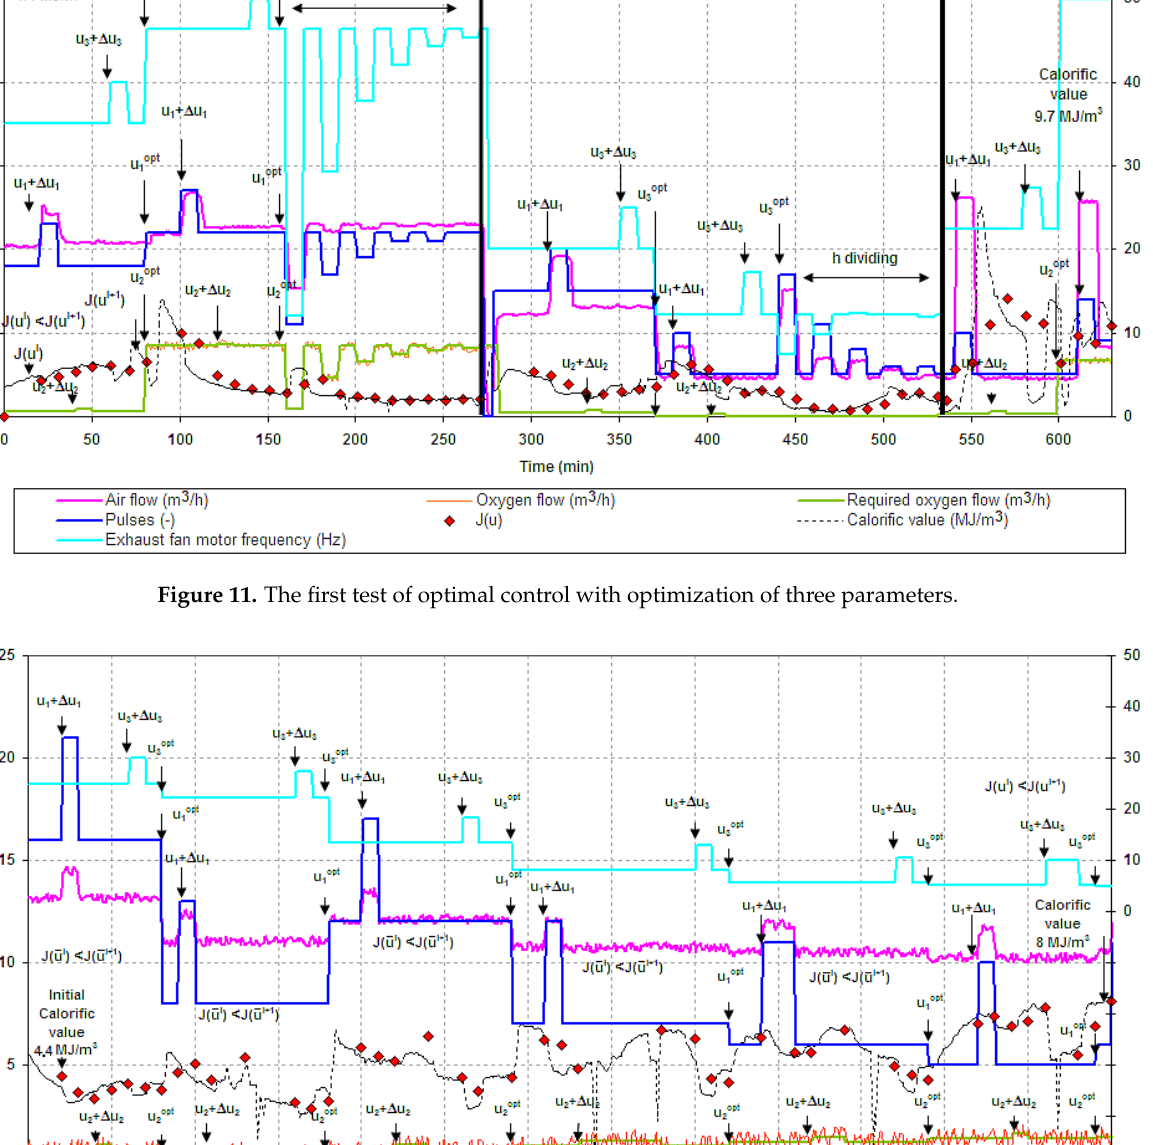
Figure 10. The second test of optimal control with optimization of two parameters.